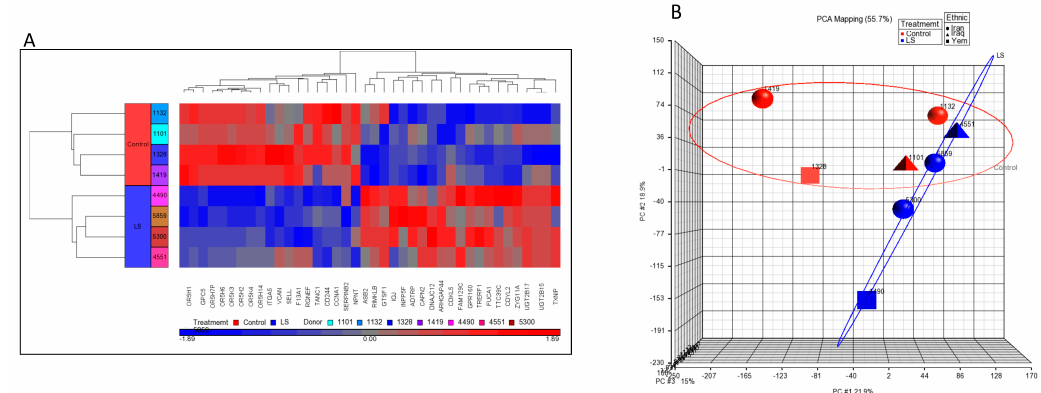
Figure 2. Genome-wide profiling of LS patients. ( a ) Cluster analysis of differentially expressed genes in Epstein-Bar virus (EBV)-immortalized lymphoblastoids derived from four LS patients (four bottom rows, blue color) and four age-, gender-, and ethnicity-matched controls (four upper rows, red color). The figure depicts a cluster of 39 differentially expressed genes (fold change (FC) > 2 or < − 2 and p value < 0.05). The names of the genes are presented in the x -axis. Up-regulated genes are shown in red and down-regulated genes are shown in blue. ( b ) Principal component analysis (PCA) display of four LS and four control arrays. Hierarchical cluster analysis was performed using Partek Genomics Suite software with Pearson’s dissimilarity correlation and average linkage methods. Data analysis was followed by one-way ANOVA. Blue circles: LS patients; red circles: controls. The figure was adapted from [55]. Table 3. Functional analysis of differentially expressed gene clusters in Laron syndrome. The table lists thirteen biological functions that were identified using the David and WebGestalt analysis platform.